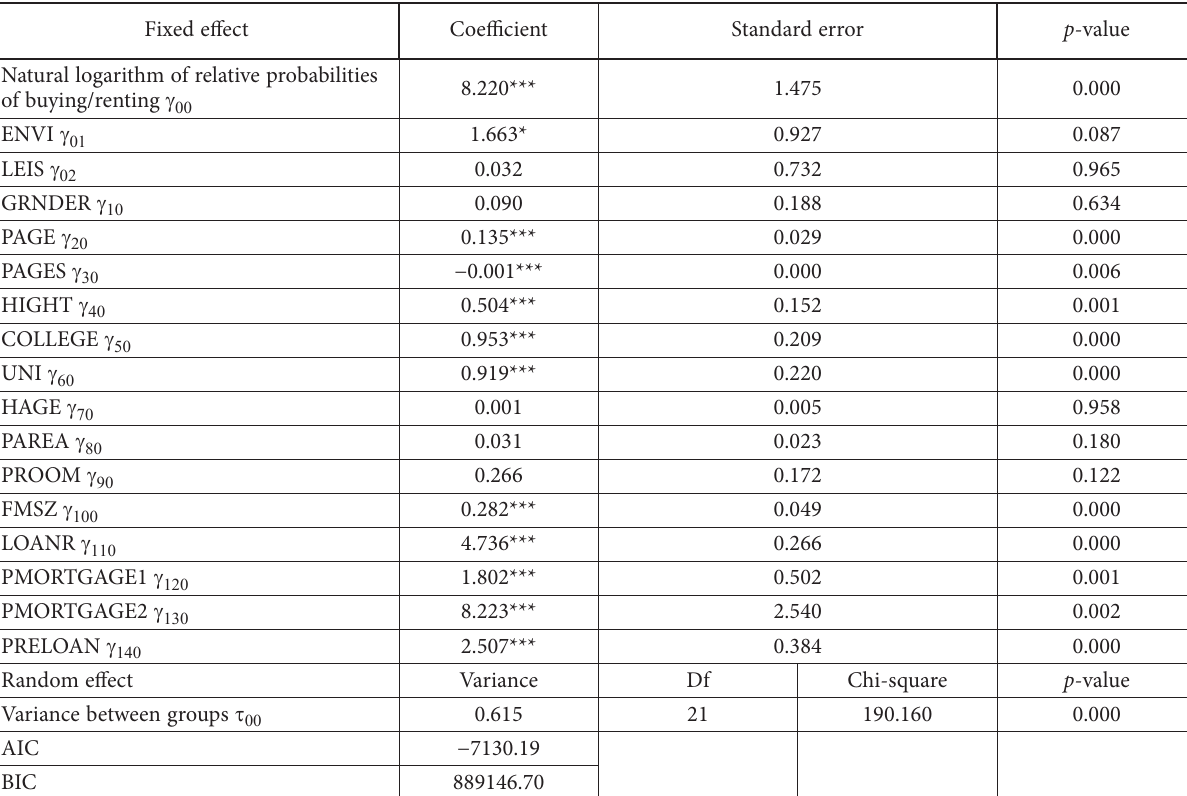
Table A1. Regression analysis with intercepts-as-outcomes